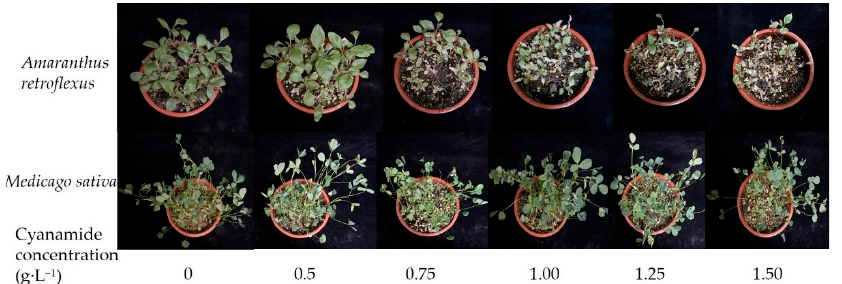
Figure 3. The effects of the two-leaf stage of alfalfa and the four-leaf stage of amaranth applied by different concentrations of CA for seven days.